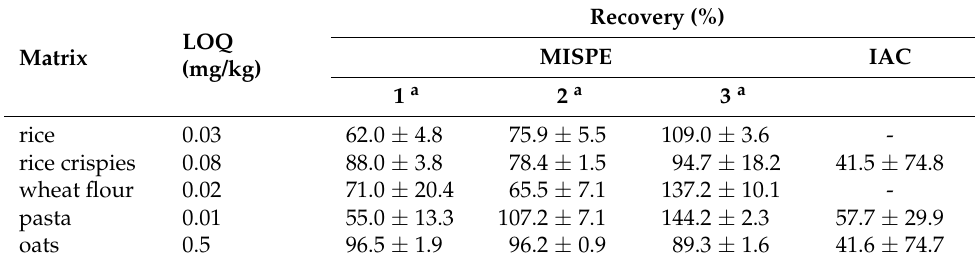
Table 3. Recovery, precision, and reusability for CIT quantification by MISPE using bulk MIP imprinted by RHO (recovery as mean ± RSD, n =